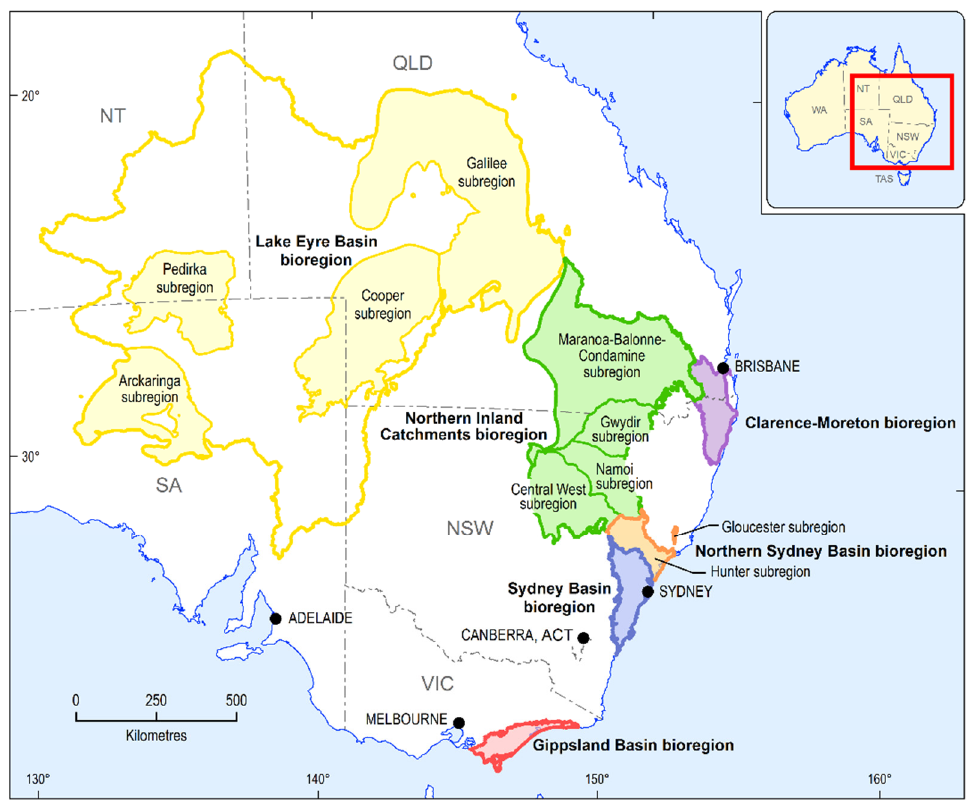
Figure 3. Bioregional Assessment Regions. Source: